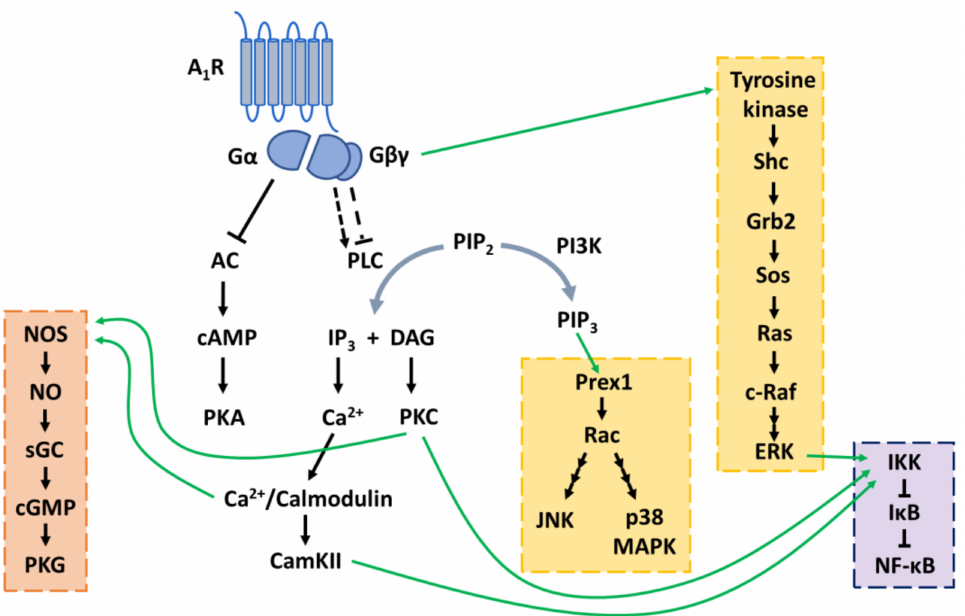
Figure 5. Activation of MAPK pathways (highlighted in yellow), the guanyl cyclase pathway (highlighted in orange) and nuclear factor- κ B (highlighted in purple) by the adenosine A 1 receptor (A 1 R). AC: adenyl cyclase; cAMP: cyclic adenosine monophosphate; PKA: protein kinase A; PLC: phospholipase C; PIP 2 : phosphatidylinositol 4,5-bisphosphate; IP 3 : inositol 1,4,5-trisphosphate; DAG: diacylglycerol; PKC: phosphokinase C; CamKII: calmodulin-dependent protein kinase II; PI3K: phosphatidylinositol 3-kinase; PIP 3 : phosphatidylinositol 3,4,5-trisphosphate; JNK: c-Jun N-terminal kinase; ERK: extracellular signal-regulated kinase; p38 MAPK: p38 mitogen-activated protein kinase; NOS: nitric oxide synthase; NO: nitric oxide; sGC: soluble guanylyl cyclase; cGMP: cyclic guanosine monophosphate; PKG: protein kinase G; IKK: I κ B kinase; NF-kB: nuclear factor- κ